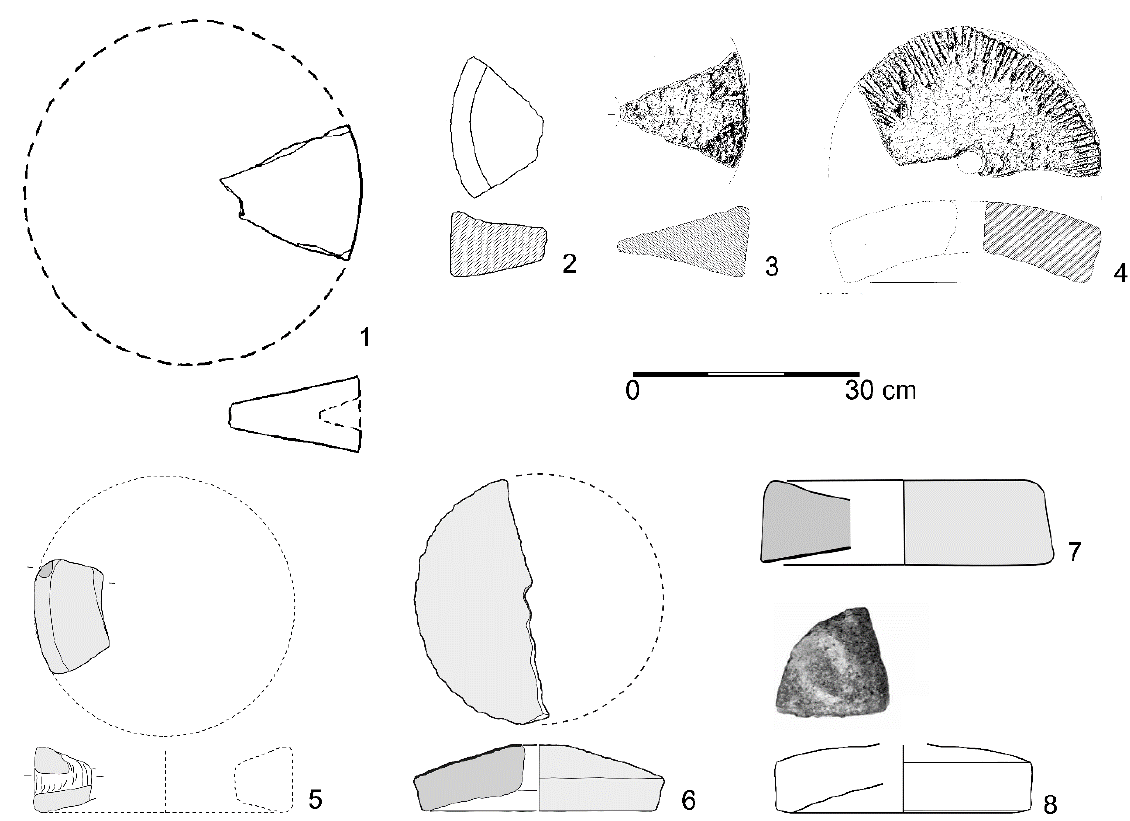
Figure 8. Quernstones of Brillerij type from Roman times. 1-3,5,7: upper stones; 4,6,8: lower stones. Provenances: 1. Augst, Kastelen; 2. Vetera near Xanten; 3-4. Briedel; 5. Hamois, Emptinne, “Champion”; 6. Meaux; 7. Bavay; 8. Avenches. (1. Schwarz 2004: fig. 128, 428; 2. Hanel 1995, pl. 164, I 19; 3-4. Joachim 1982b: pl. 8:24, 22:11; 5. van Ossel & Defgnée 2001: fig. 145:5; 6. Lepareux-Couturier et al . 2011: fig. 27;